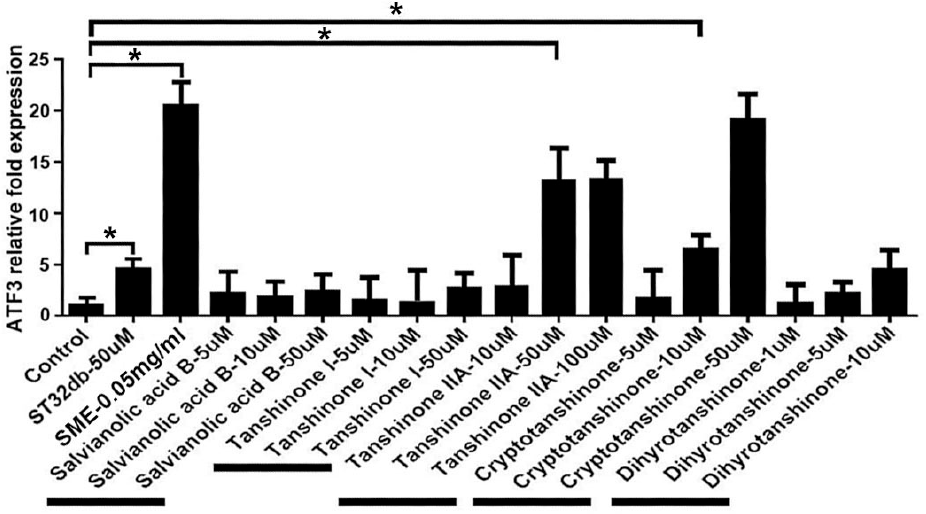
Figure 4. Upregulation of ATF3 expression was by purified single compounds derived from S. miltiorrhiza . 3T3-L1 cells were treated with single compounds as indicated, and real-time PCR analysis was conducted to determine ATF3 gene mRNA levels. Diagram represents the real-time PCR results from three independent experiments. Data are the mean ± SEM; * p < 0.05 compared with control. 3.5. Individual Compounds as ATF3 Inducers Ameliorate HFD-Induced Metabolic Dyshomeo-